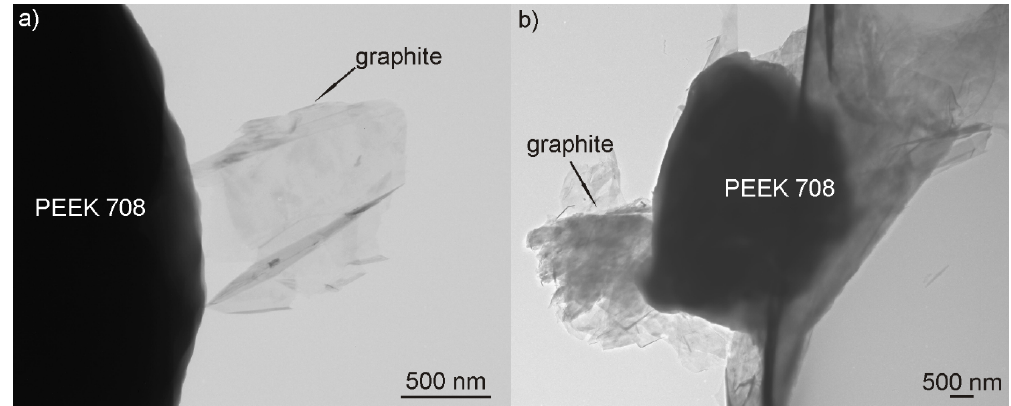
Figure 4. TEM images of the graphite particles adsorbed to the PEEK 708 microparticle in the suspension used for electrophoretic deposition (EPD) containing 1 g/L ( a ) and 2 g/L ( b ) of graphite. In the case of the suspension containing 1 g/L of graphite the PEEK particles are covered only partially.